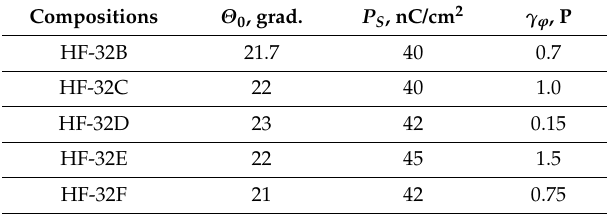
Table 1. Investigated helix-free ferroelectric liquid crystals (FLC) compositions.